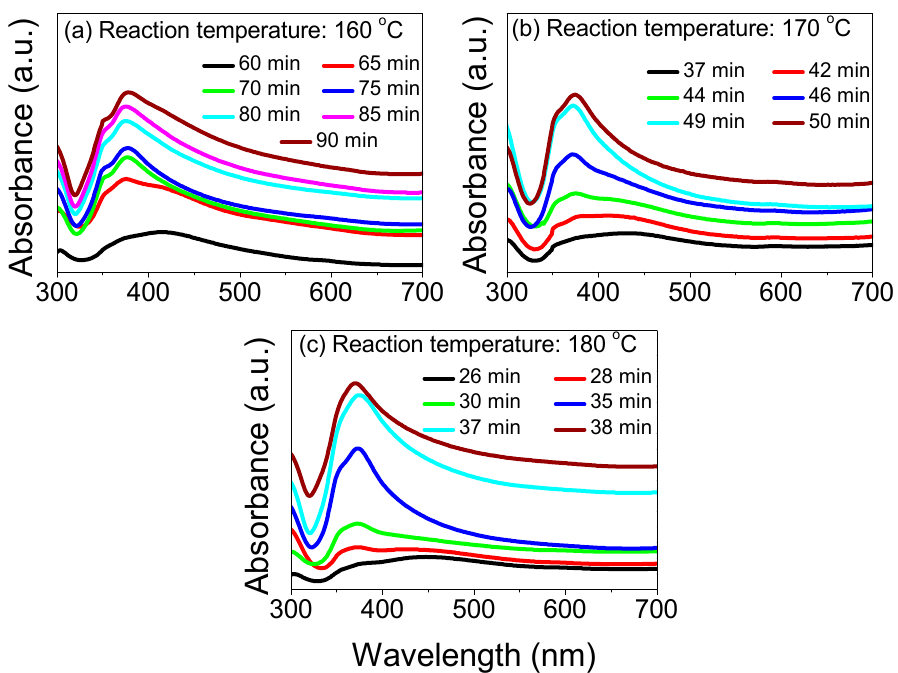
Figure 3. The absorbance of AgNWs suspension for the growth duration in the range of ( a ) 60–90 min at a reaction temperature of 160 °C , ( b ) 37–50 min at a reaction temperature of 170 °C, and ( c ) 26–38 min at a reaction temperature of 180 °C .